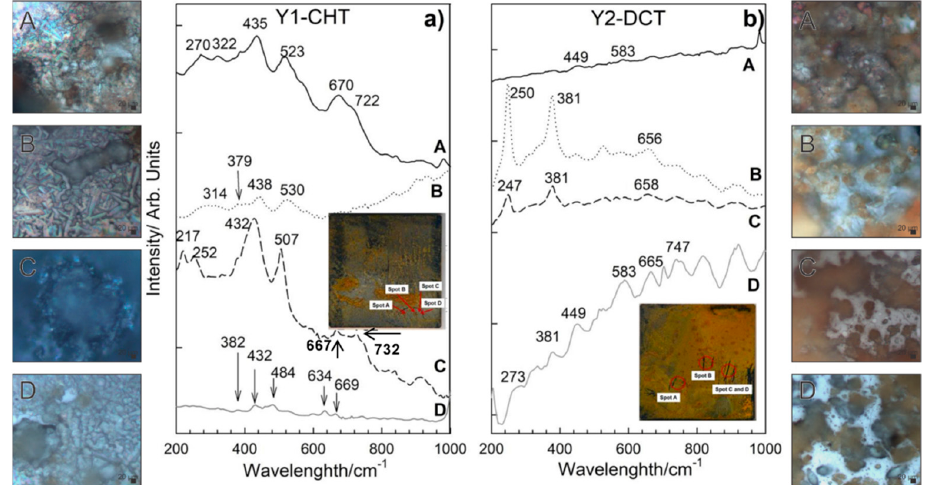
Figure 7. Raman spectra of corrosion products formed on steel samples Y1-CHT ( a ) and Y2-DCT ( b ) after 1 day exposure to seawater. Both spectra are also accompanied by light microscopy images ( A – D ) of corrosion products obtained at 1000× magnification.